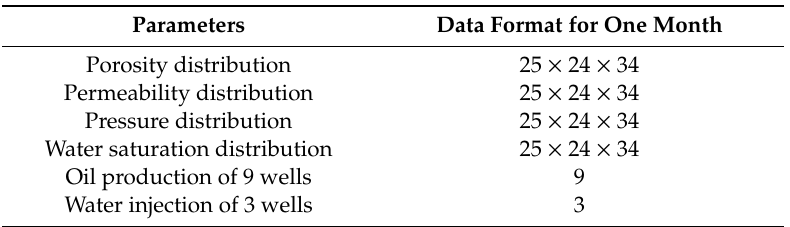
Table 1. Input parameters information in the